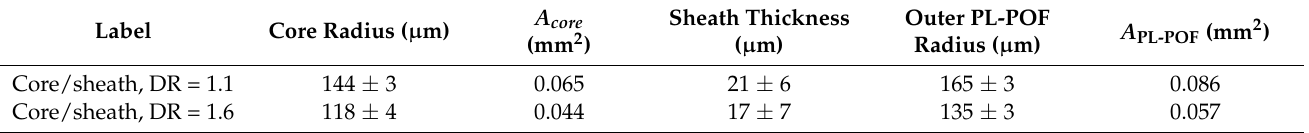
Table 2. Dimensions of